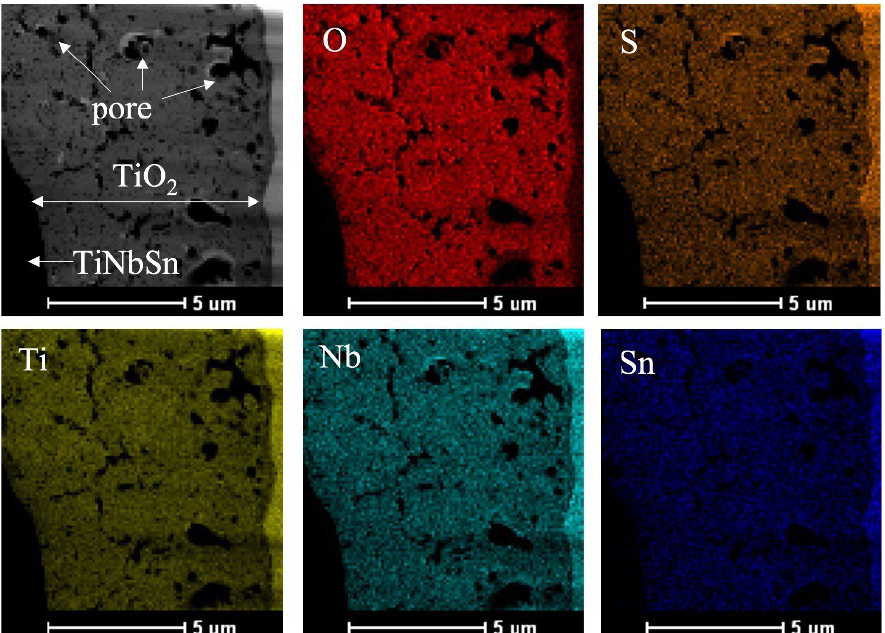
Figure 11. TEM micrographs and EDX elemental mapping of the annealed anodic oxides pre- pared in an electrolyte with sulfuric acid . Cross-sectional TEM micrographs and EDX elemental mapping of annealed anodic oxides prepared in an electrolyte with a sulfuric acid concentration of 1.2 M. TEM: Transmission electron microscope; EDX: Energy dispersive X-ray spectroscopy